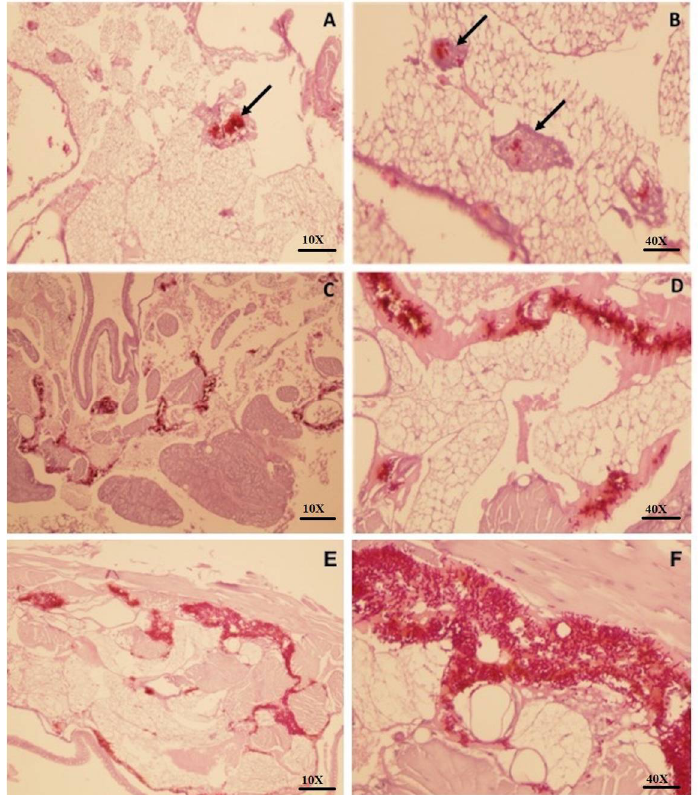
Figure 3. Galleria mellonella larvae were infected with 5 × 10 4 yeasts of C. auris and C. haemulonii complex and sacrificed 3 h or 3 days after infection, respectively. The tissue was preserved in formalin and then stained with periodic acid–Schiff (PAS). ( A ) Larvae infected with C. haemulonii complex 10×; and then stained with periodic acid–Schi ff (PAS). ( A ) Larvae infected with C. haemulonii complex 10 × ; ( B ) larvae infected with C. haemulonii complex 40 × ; ( C ) larvae infected with C. auris (432) 10 × ; ( B ) larvae infected with C. haemulonii complex 40×; ( C ) larvae infected with C. auris (432) 10×; ( D ) ( D ) larvae infected with C. auris (432) 40 × ; ( E ) larvae infected with C. auris (386) 10 × ; ( F ) larvae infected larvae infected with C. auris (432) 40×; ( E ) larvae infected with C. auris (386) 10×; ( F ) larvae infected with C. auris (386) 40 × . Black arrows show granuloma-like cell aggregates in the with C. auris (386) 40×. Black arrows show granuloma-like cell aggregates in the tissue.